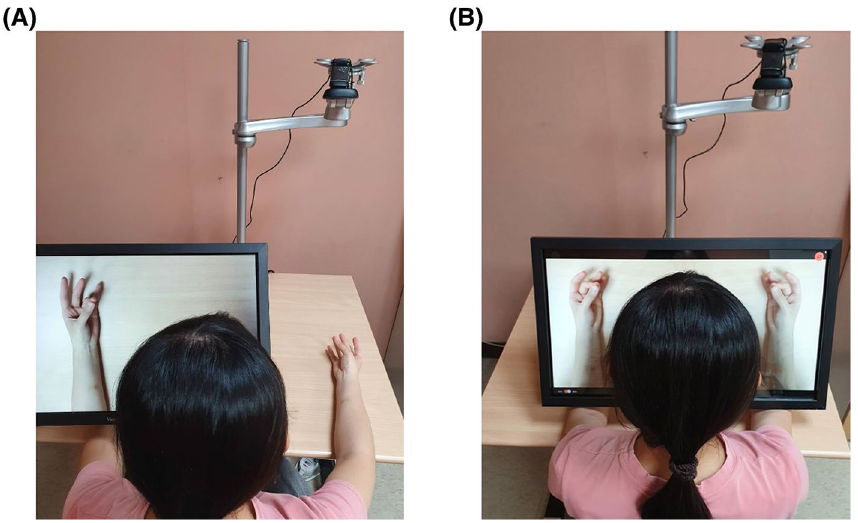
Figure 2. Demonstrations of digital mirror therapy: ( A ) unilateral mode, and ( B ) bilateral mode. ( A ) The movements of the user’s non-affected hand (e.g., right hand) can be recorded by the webcam, instantly transformed into mirror images of the affected hand’s movements (e.g., left hand), and presented on the screen by the self-developed software. ( B ) The movements of the patient’s non-affected hand can also be recorded, instantly transformed into mirror images of movements of both hands, and simultaneously presented on the